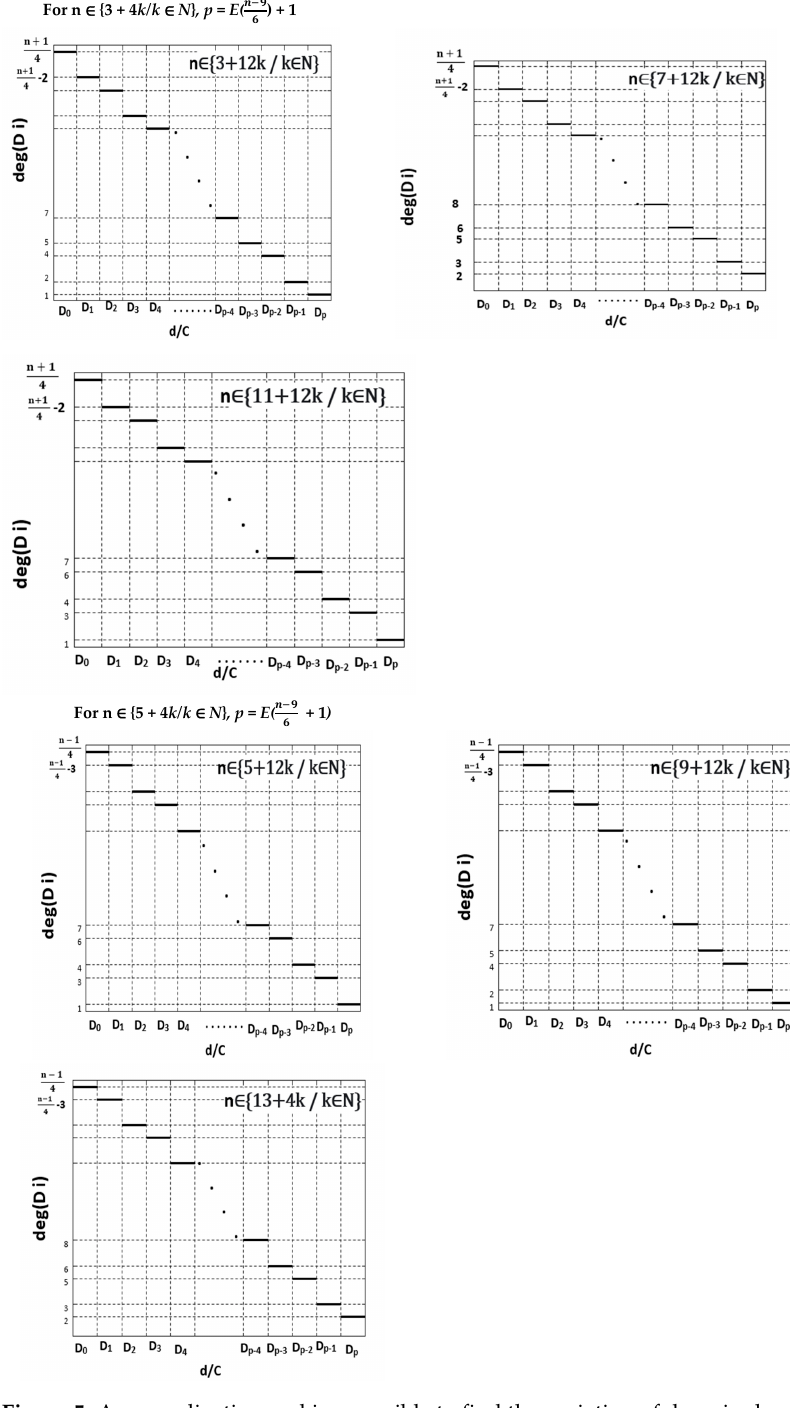
Figure 5. A generalization making possible to find the variation of domain degeneracy for any odd number of vaccination centres.